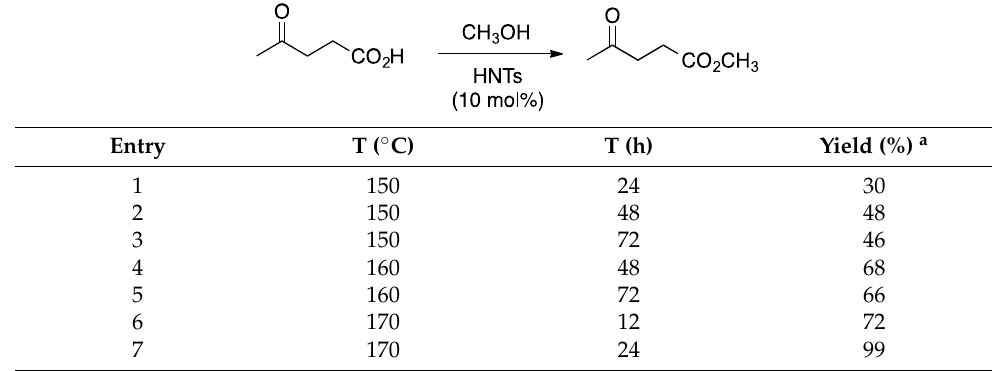
Table 4. Optimization of experimental conditions for esterification on levulinic acid with methanol.